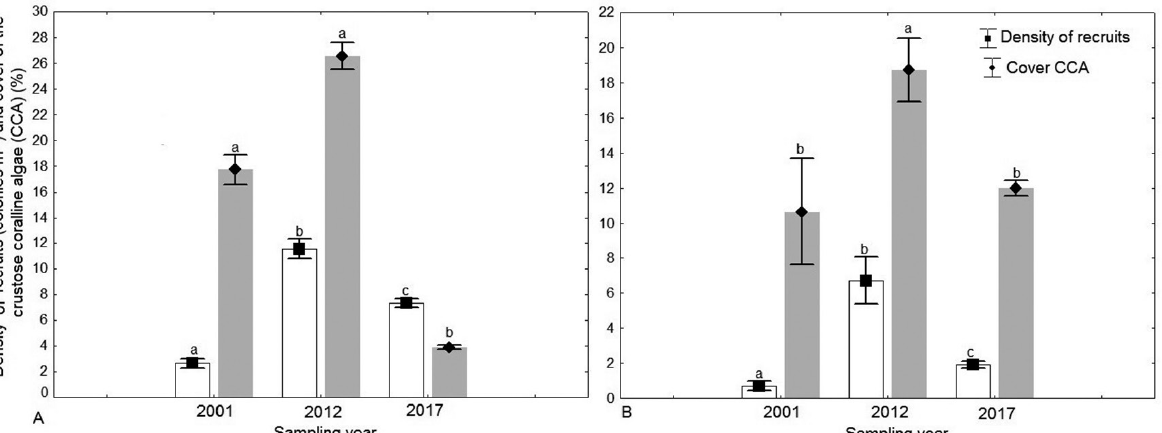
Fig. 7. – Recruit density (colonies m –2 ) and cover of crustose coralline algae on the fore reef (A) and reef crests (B) in 2001, 2012 and 2017. A, recruit (df=2, p-value=5.578e-07), cover (df=2, p-value < 2.2e-16). B, recruit (df=2, p-value=0.000634), cover (df=2,